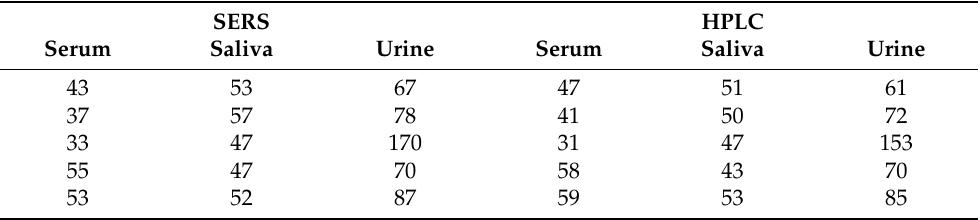
Table 3. SERS and HPLC methods for hypoxanthine concentration detection